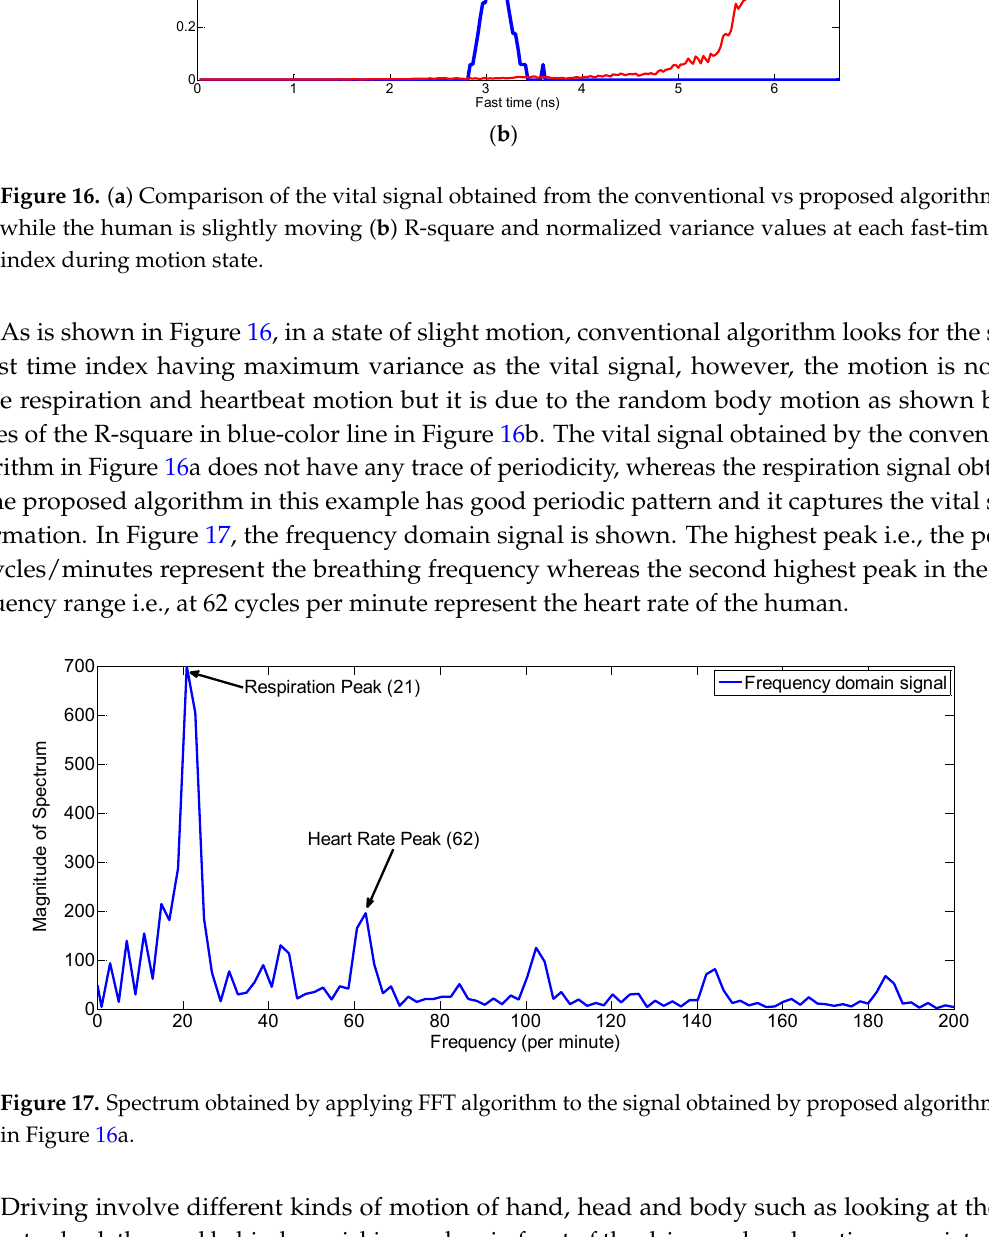
Figure 17. Spectrum obtained by applying FFT algorithm to the signal obtained by proposed algorithm in Figure 16(a).